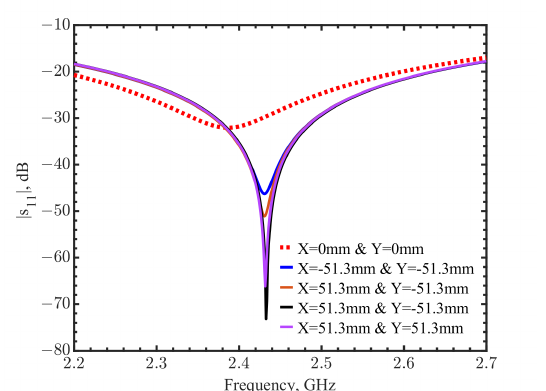
Figure 6. Comparison of reflection coefficients at the center (dashed line) and four near corners (solid line). The tumor is at the center as (x = 0, y = 0).